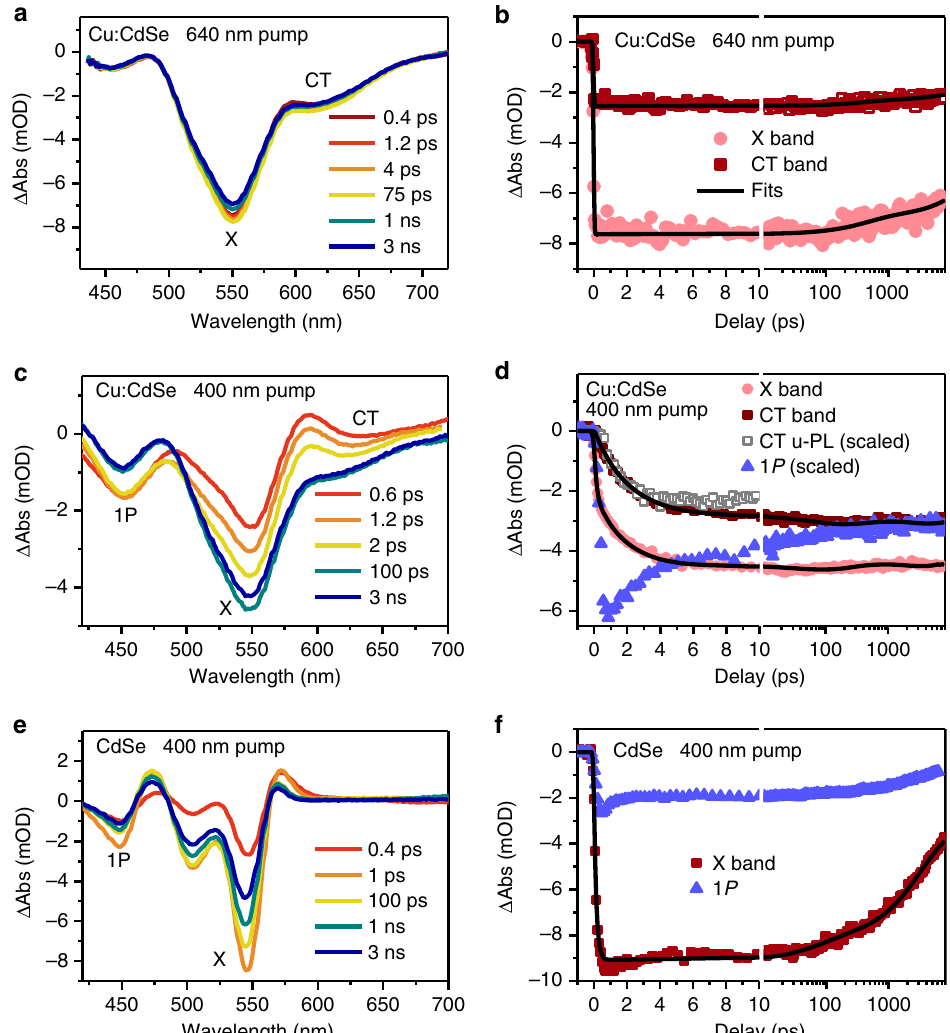
Fig. 4 Hot electron relaxation in Cu-doped QDs. a TA spectra of Cu:CdSe QDs probed at indicated time delays following the excitation by a 640-nm pulse. b TA kinetics probed at the X (light red circles) and CT (dark red squares) band bleaches following the excitation by a 640-nm pulse. c TA spectra of Cu: CdSe QDs probed at indicated time delays following the excitation by a 400-nm pulse. d TA kinetics probed at the X (light red circles), CT (dark red squares), and 1 P (blue triangles) band bleaches following the excitation by a 400-nm pulse. Note that the CT and 1 P band signals have been ampli fi ed by factors of 3 and 4, respectively. Also shown is the u-PL kinetics of CT band emission (scaled and inverted; gray open squares) measured under 400 nm excitation with < N >~ 4. e , f Similar plots as ( c , d ) for undoped CdSe